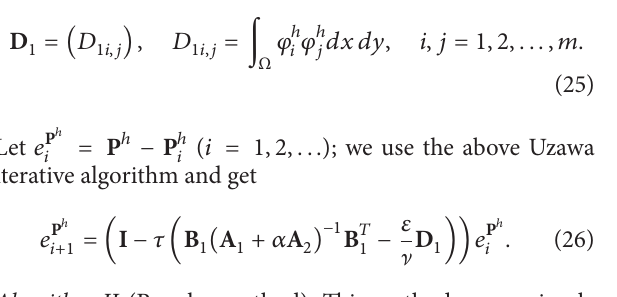
Algorithm II (Regular method). This method uses a simple way to stabilize the mixed finite element approximation